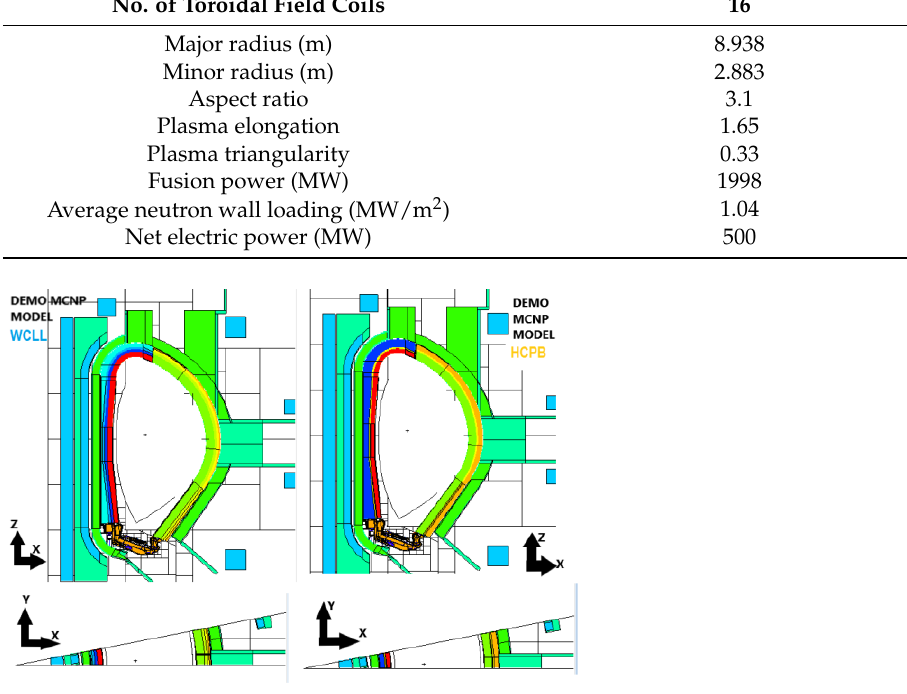
Figure 4. WCLL ( left ) and HCPB ( right ) DEMO single module semi-heterogeneous MCNP models, with divertor 2019 cassette body [27,43].